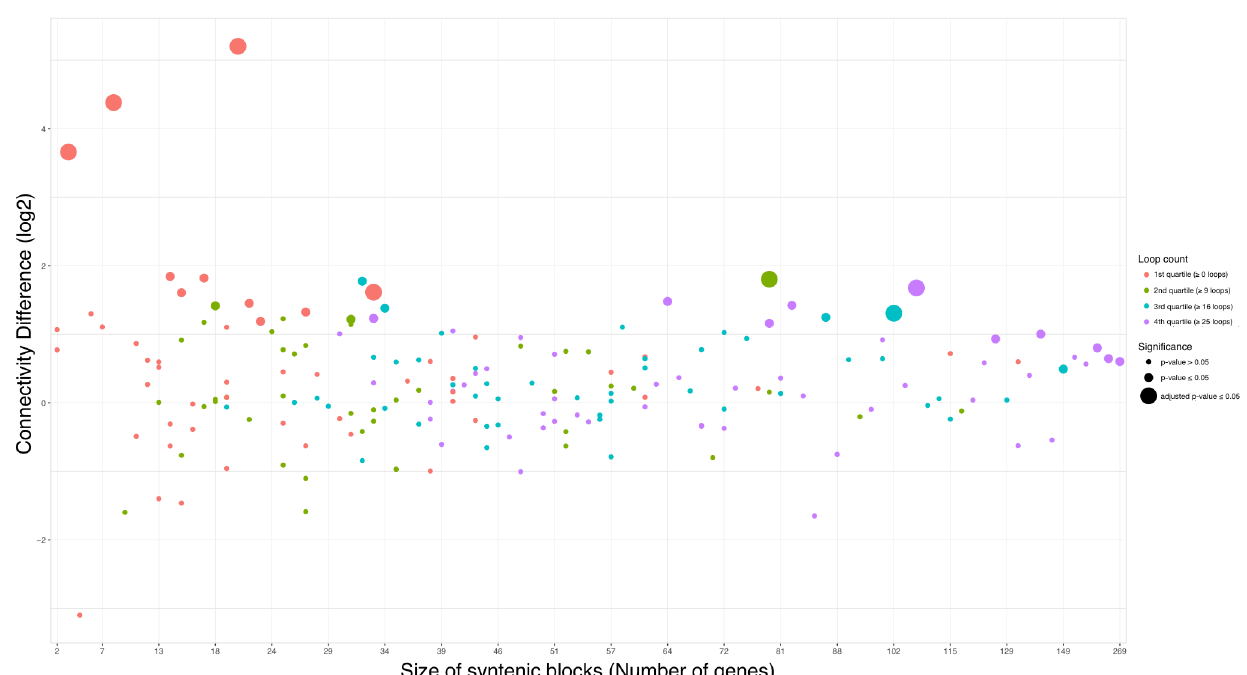
Fig 3. Distribution of chromatin loops in conservedsyntenic blocks. Rao et al . (2014) definedchromatinloops associated with coordinated gene expression. Shownis the distribution of chromatinloops per conservedsyntenic block. The colors represent quartile1–4 for the loops per block distribution. Dot size indicateswhetherthe block had significantly high connectivity or not. We found an enrichment of chromatinloops in the conservedsyntenic blocks with observedhigh confident PPIs, but no correlationbetweenincreasing connectivityand increasedloop